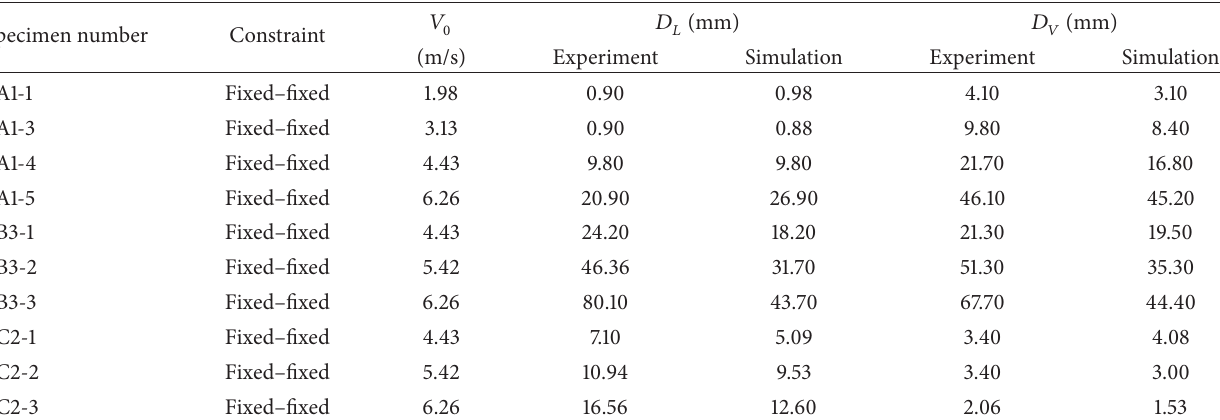
Table 3: Comparisons of deflection on mid-span from tests and numerical simulations.